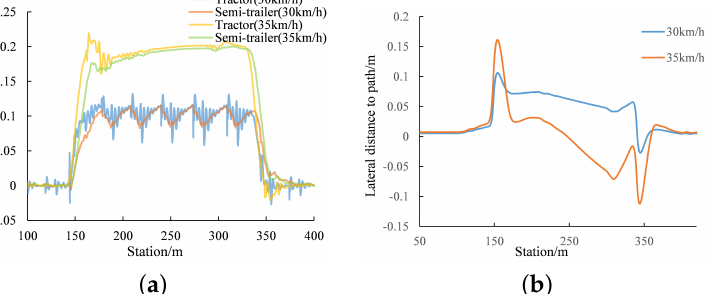
Figure 10. ( a ) Lateral acceleration and ( b ) lateral displacement of tractor-trailer for wind speeds of 68 km/h.